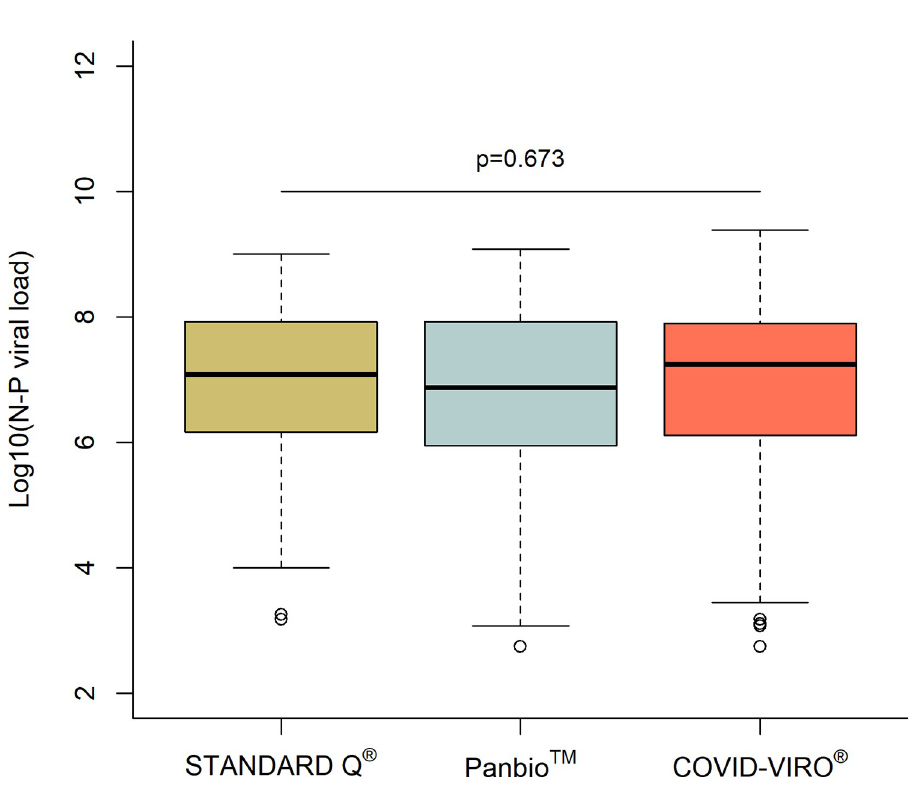
Fig 5. Log viral loads by NP PCR according to the RDT brand used.